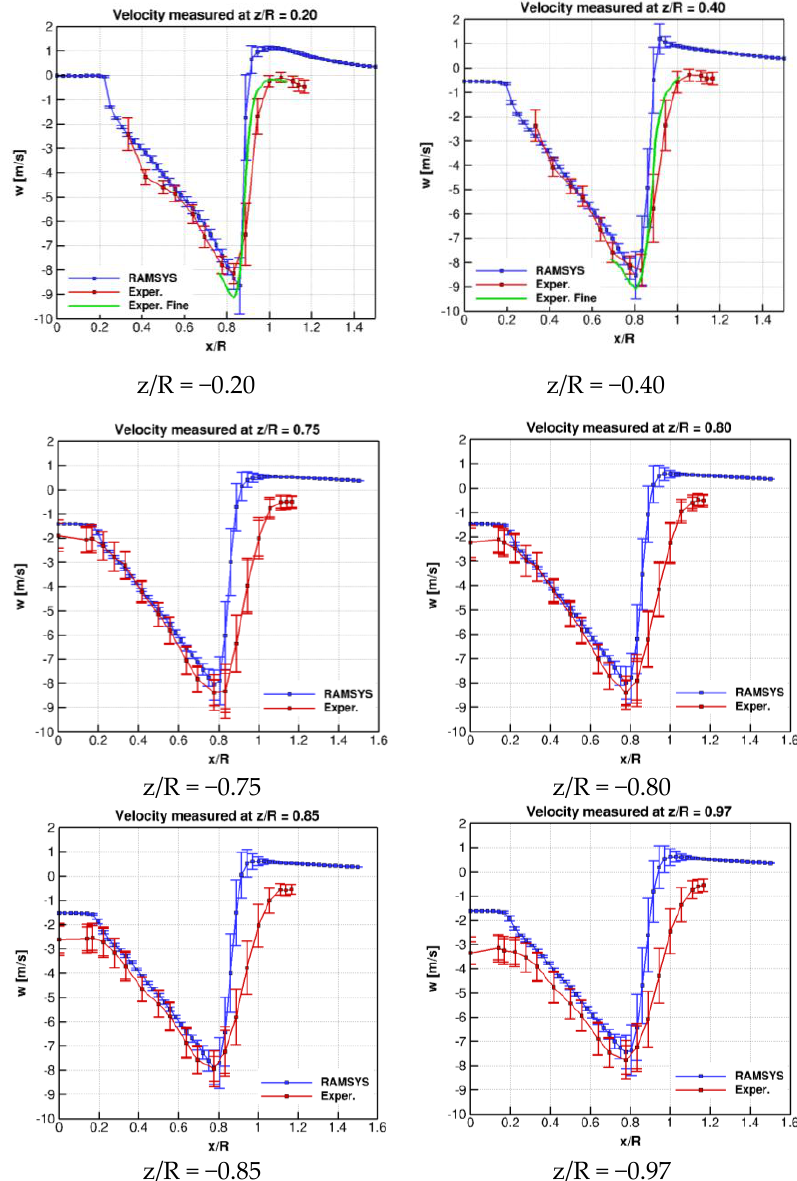
Figure 9. PIV vs. numerical vertical velocity comparison.